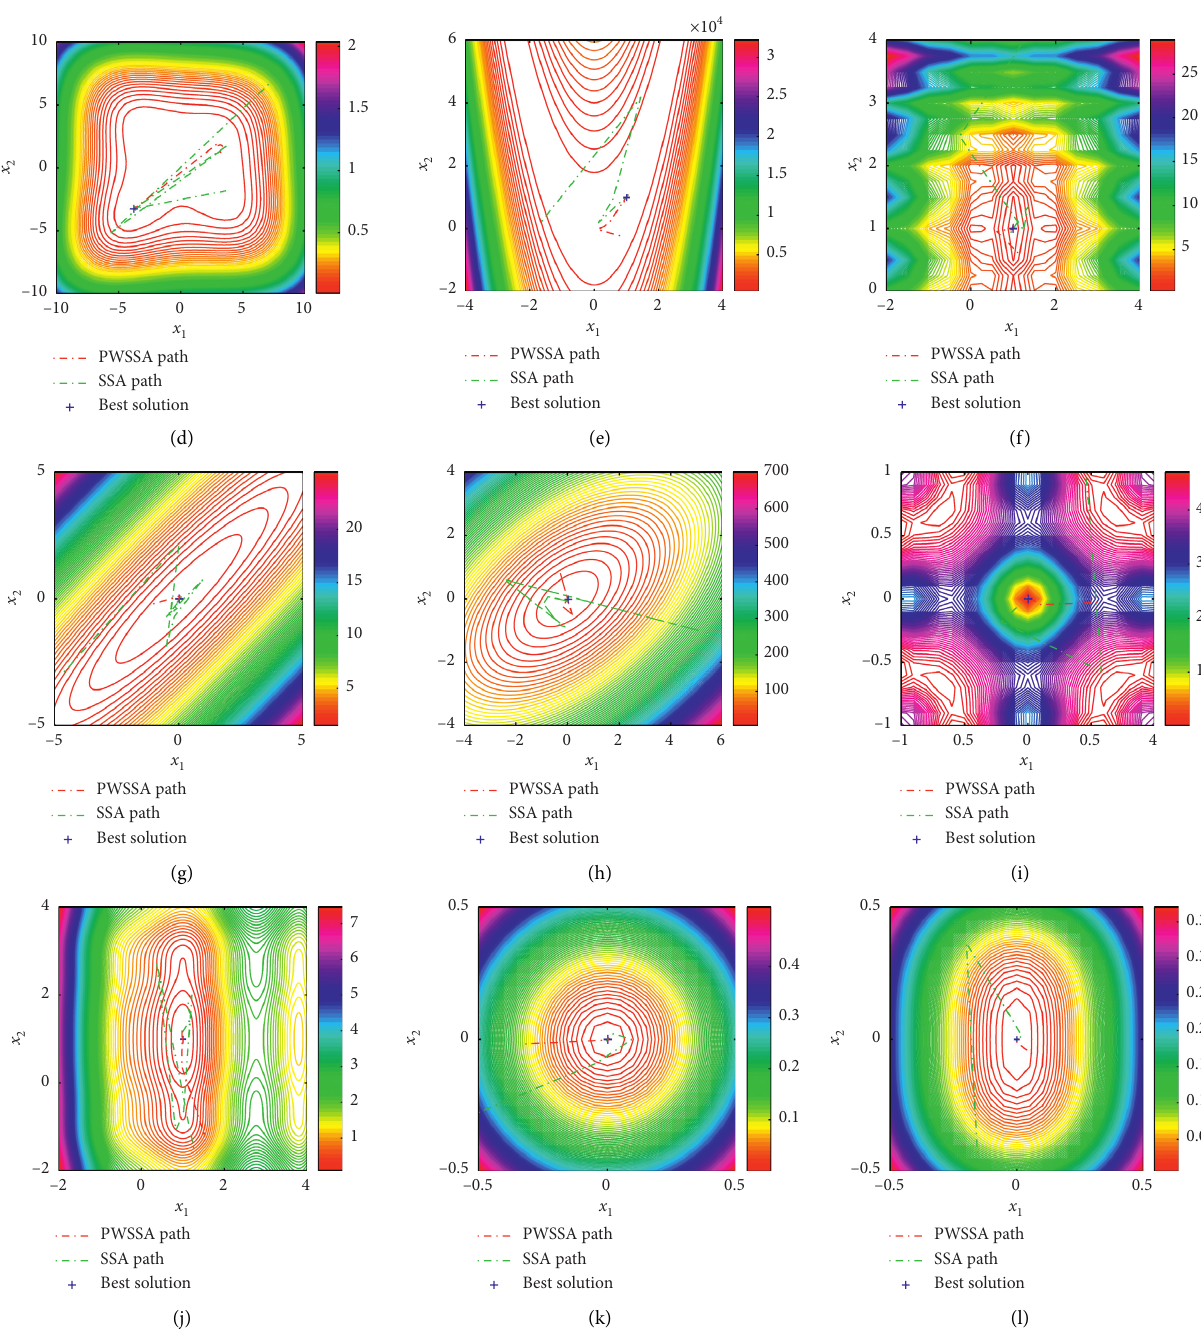
Figure 6: Comparison of searching paths. (a) f 1 . (b) f 2 . (c) f 3 . (d) f 4 . (e) f 5 . (f) f 6 . (g) f 7 . (h) f 8 . (i) f 9( D � 2) . (j) f 10( D � 2) . (k) f 11( D � 2) . (l) f 12( D � 2)